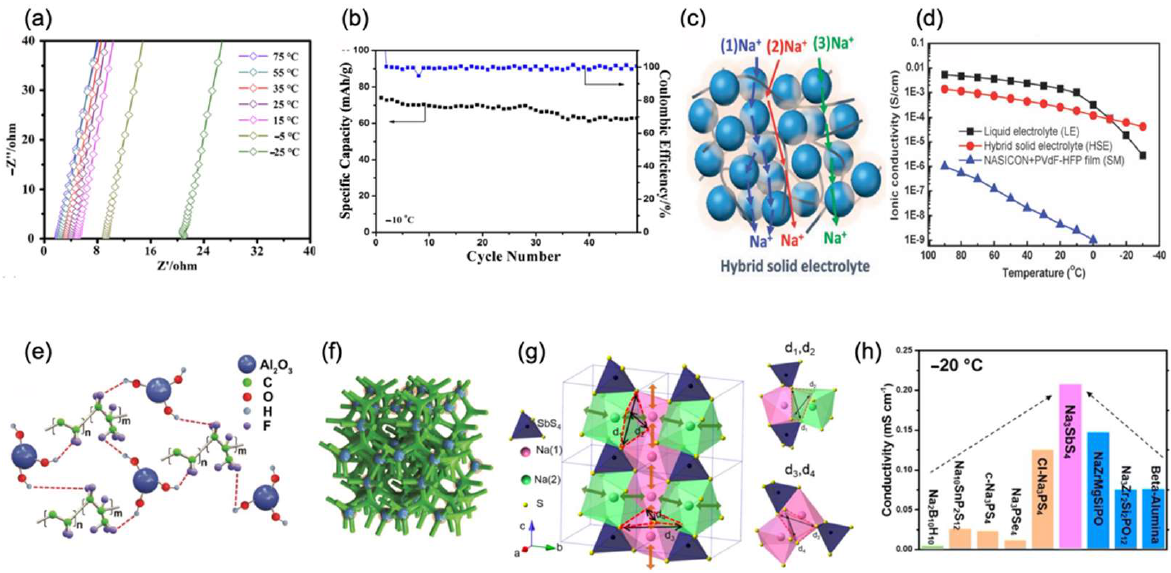
Figure 12. ( a ) AC impedance spectra of PFSA-Na at different temperatures. Reproduced with permission from Ref. [77]. Copyright 2020 Wiley-VCH GmbH. ( b ) Electrochemical performance of NVP/Na half-cell using (flame-retardant quasi-solid polymer electrolyte) FRPMM-CPE after 50 cy- cles at −10 °C. Reproduced with permission from Ref. [78]. Copyright 2018 American Chemical So- ciety. ( c ) Na + hopping pathways in the hybrid solid electrolyte. Reproduced with permission from Ref. [80]. Copyright The Royal Society of Chemistry 2015. ( d ) Ionic conductivity comparison of the solid film, liquid electrolyte, and hybrid solid electrolyte. ( e ) Constitutional unit of PVDF-HFP and Al 2 O 3 nanoparticles. ( f ) Three-dimensional schematic illustration of the PVDF-HFP three-dimen- sionally cross-linked structure. Reproduced with permission from Ref. [81]. Copyright 2019 WILEY- VCH Verlag GmbH & Co. KGaA, Weinheim. ( g ) Three-dimensional model of the Na 3 SbS 4 frame- work. Structure of the tetragonal Na3SbS4 framework (note: the relative radii of spheres do not represent the real atom sizes) with conduction paths of Na(1)-Na(1) (along z-axis) and Na(1)-Na(2) (in xy-plane). The right schematic display is magnified to show the S-gates (d 1 , d 2 , d 3 , d 4 ) and the contractions. ( h ) Comparison of the solid Na 3 SbS 4 electrolyte with the most reported solid electro- lytes. Reproduced with permission from Ref. [82]. Copyright 2018 American Chemical Society.